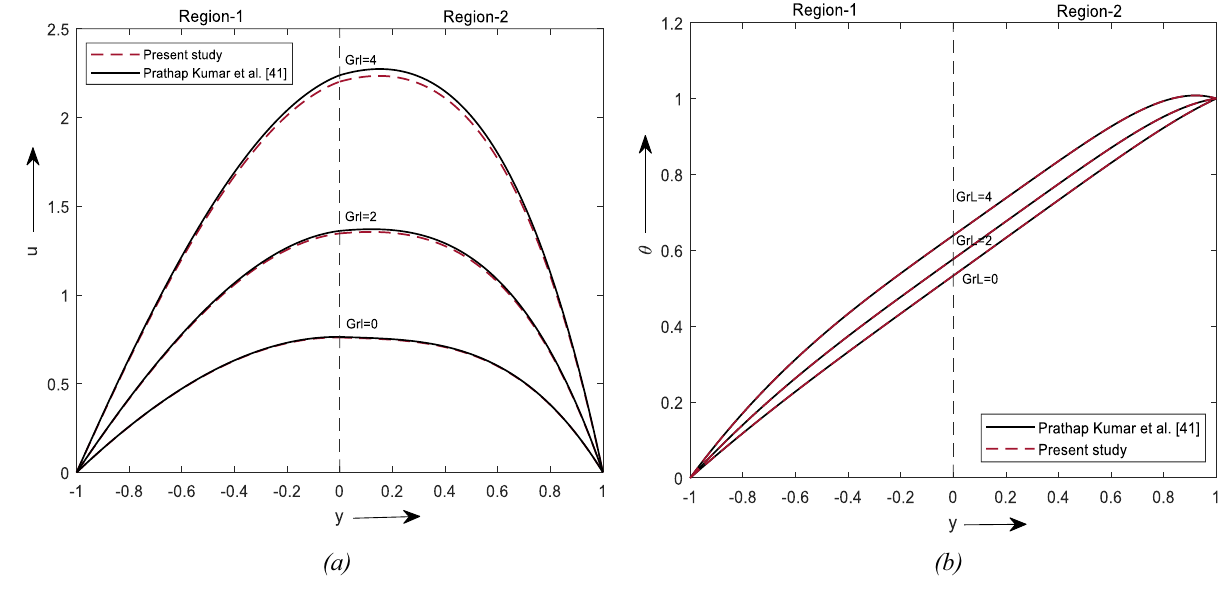
Figure 10. Comparison results of ( a ) velocity profile. ( b ) Temperature